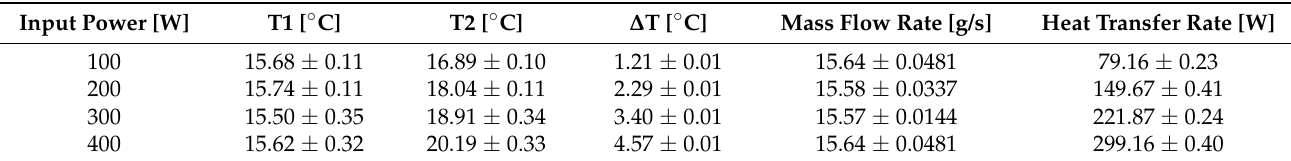
Table 3. Experimental thermal results for different input power